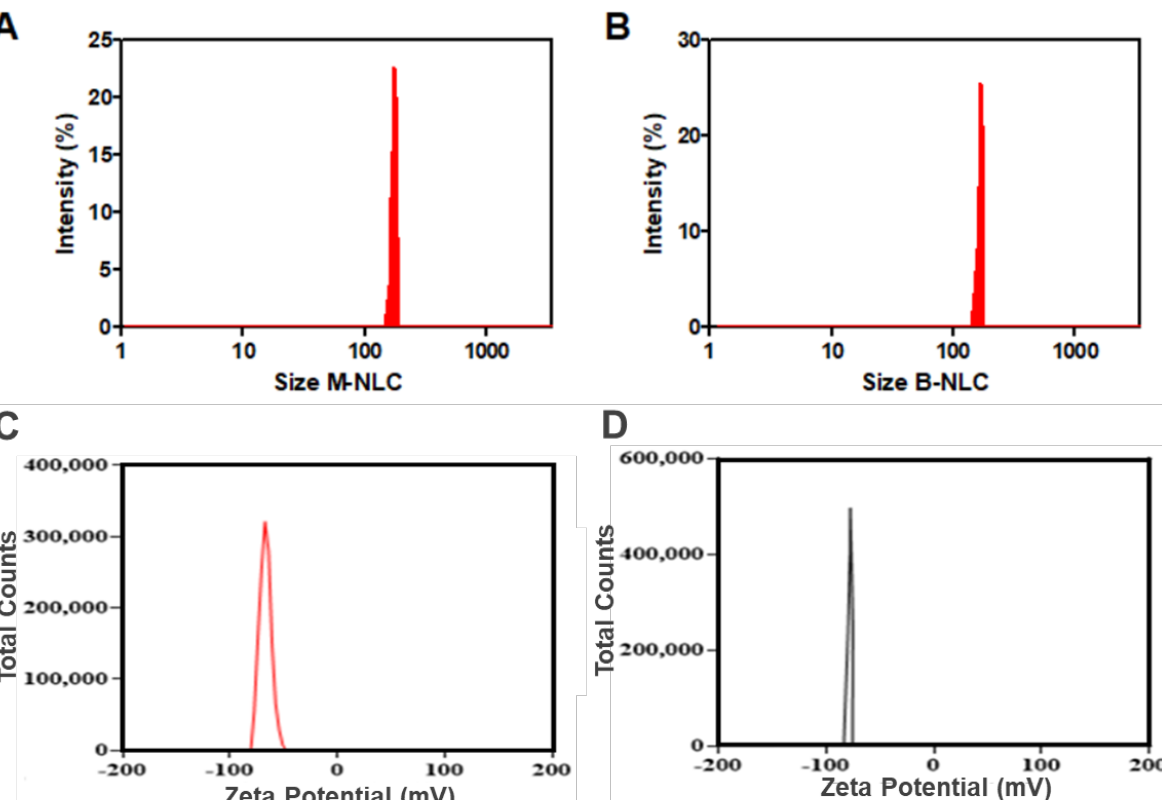
Figure 5. Particle size analysis. Size distribution of M-Ext-loaded NLCs ( A ) and blank NLCs ( B ). Zeta-potential of M-Ext loaded NLCs ( C ) and blank NLCs ( D ). Data shown as means ± SD ( n = 3).